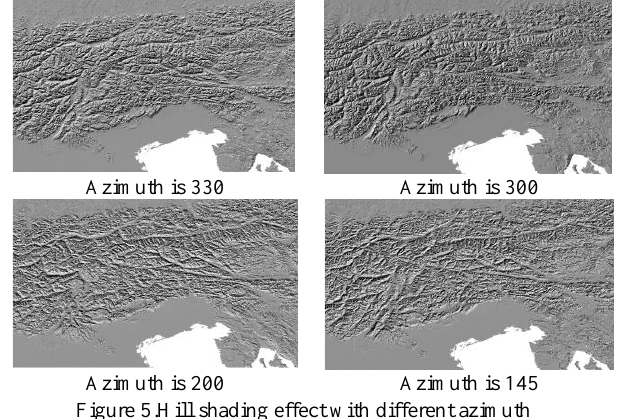
Figure 5.Hill shading effect with different azimuth As well as, the Z factor, that is to convert the elevation units to horizontal coordinated units of the dataset and to add vertical exaggeration for visual effect, changes as the different scales in TIANDITU and the SRTM 90m data.